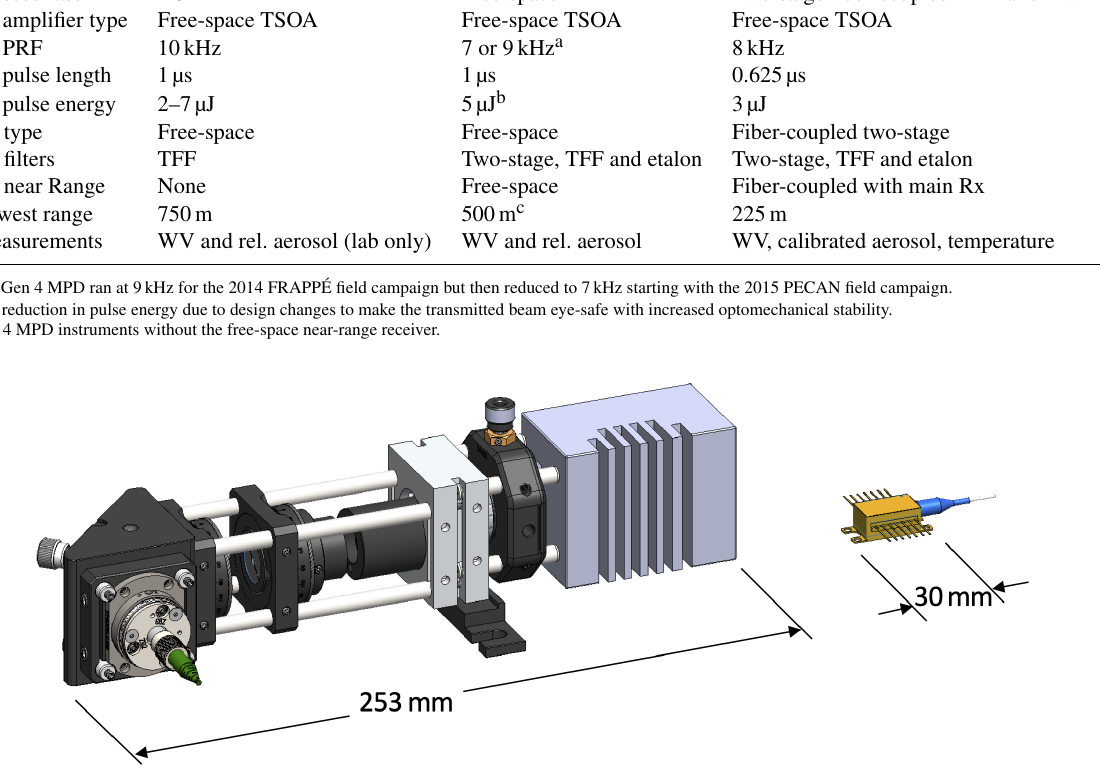
Figure 4. Solid model of the free-space seed laser package (left) and the butterfly-packaged seed laser (right). These devices are essentially the same in the sense that they provide several milliwatts of continuous-wave laser light in single-mode fiber; however, the optomechanical stability and the knowledge required to align them are substantially different. The butterfly package’s heat sink, which has a footprint of approximately 90mm × 90mm, is not